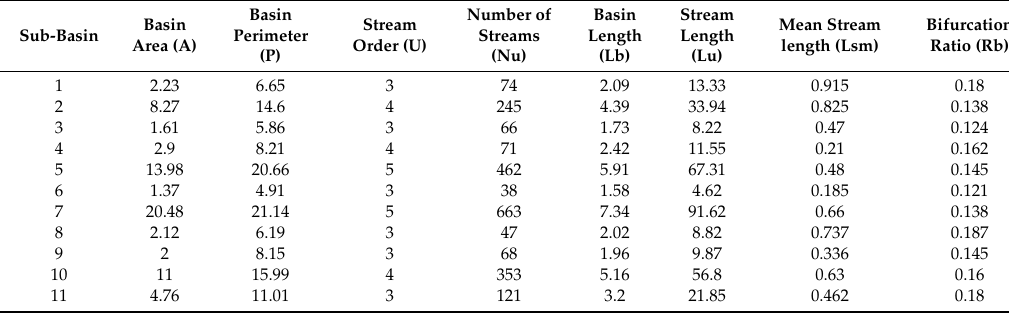
Table 4. Basic morphometric parameters of Kalv¯ar¯ı